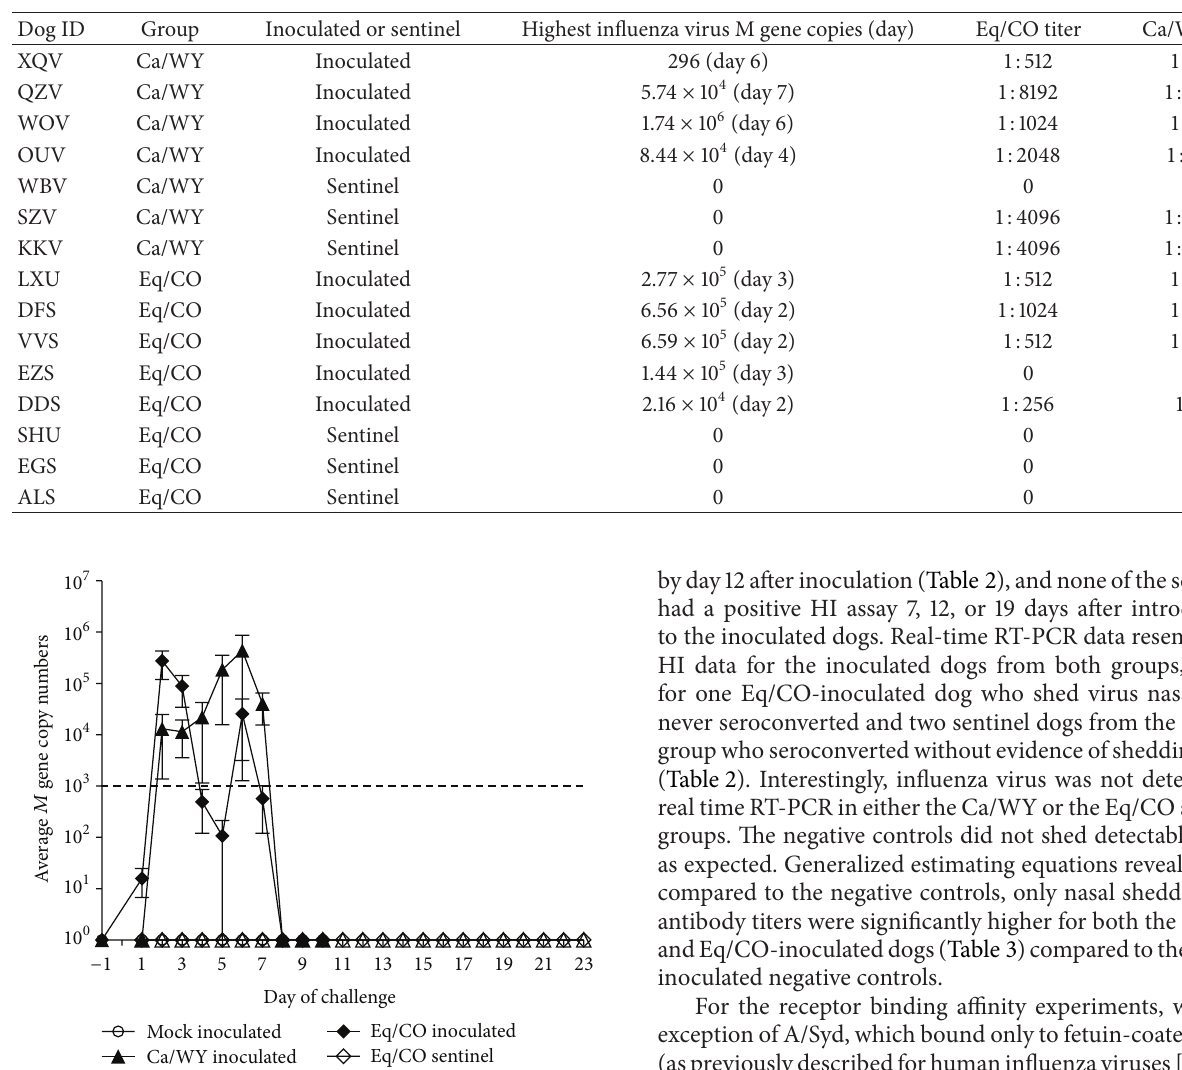
Table 2: Nasal shedding of the influenza virus M gene detected on real time RT-PCR and hemagglutination inhibition assay titers to Eq/CO and Ca/WY isolates 12 days after virus inoculation or introduction to inoculated dogs.